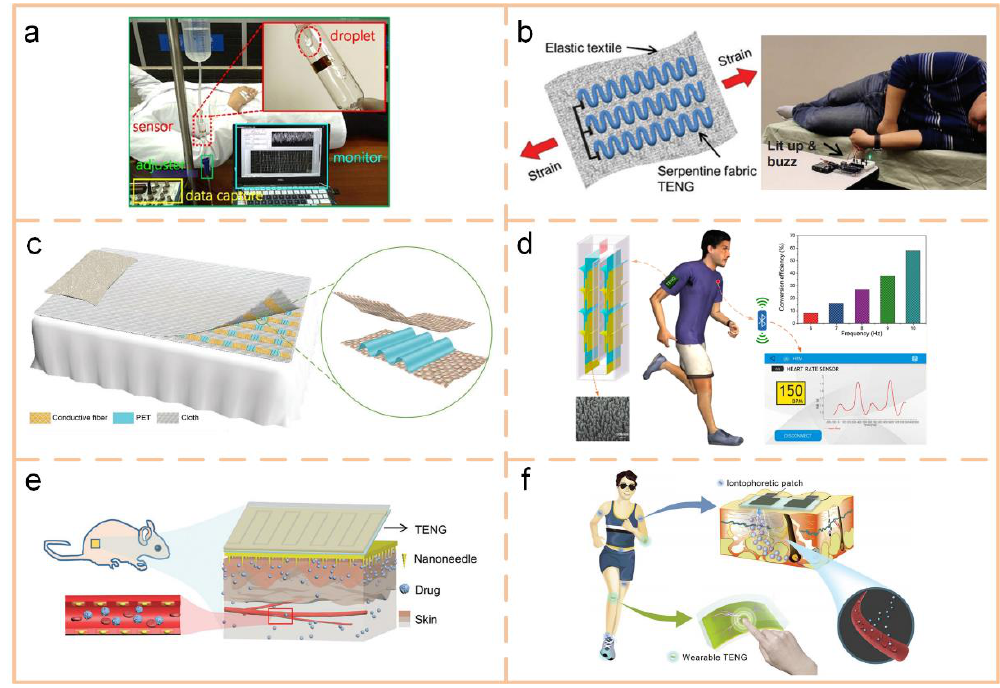
Figure 14. Some smart applications. ( a ) Infusion monitor using a self-powered triboelectric